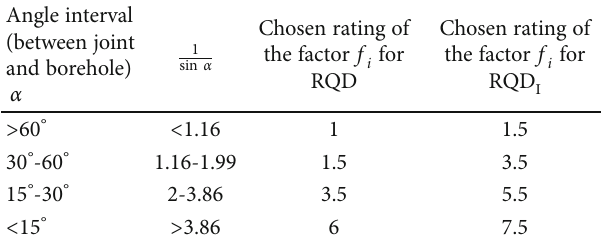
Table 2: Angle intervals and ratings of the factor for each interval